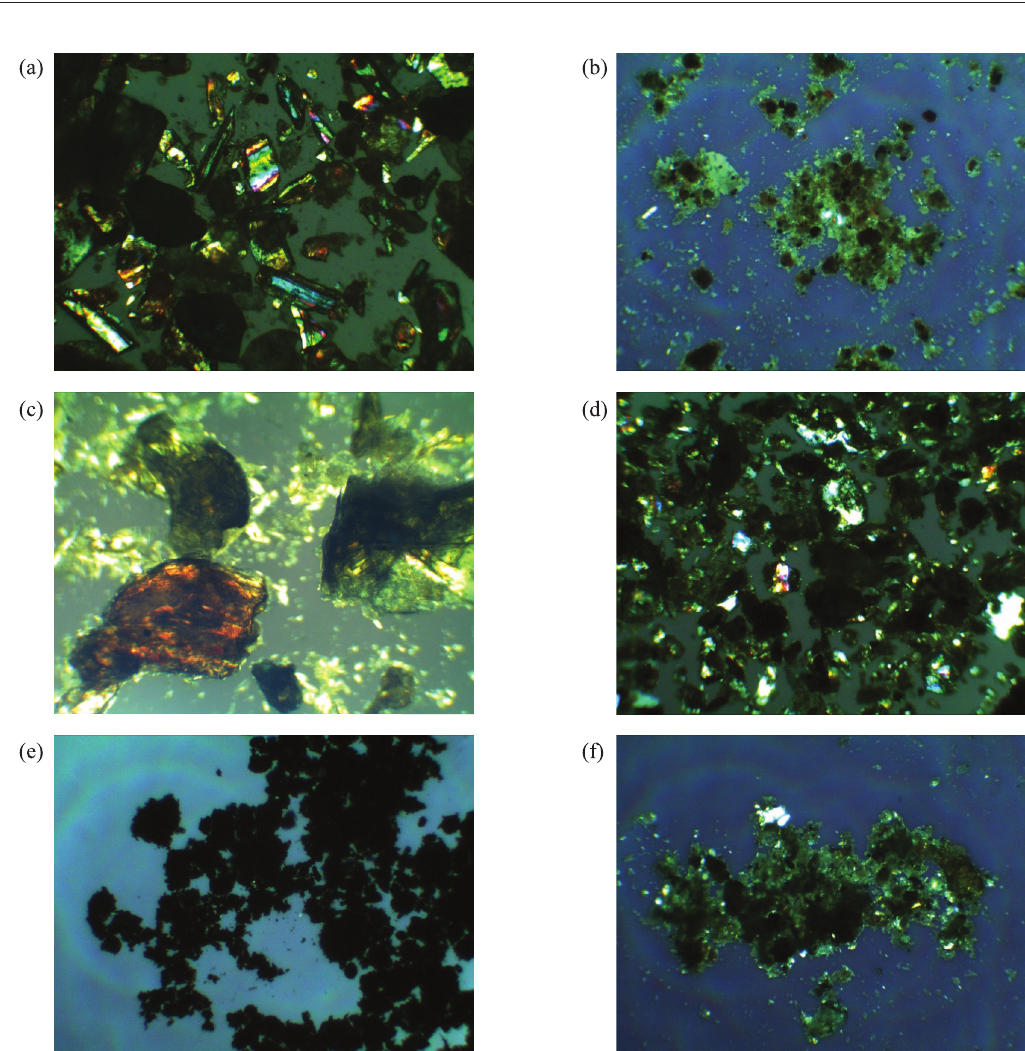
figure 1. Photomicrography (XPl) of biote schist (a), breccia (b), phlogopite schist (c), Chapada mining byproduct (CmB) (d), mining byproduct (mB) (e) and ultramafic rock (f). Picture width corresponding to 2.3